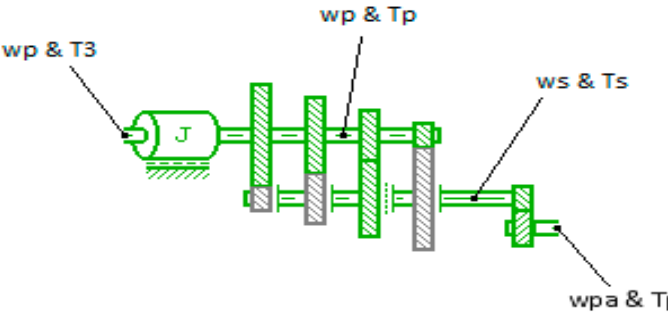
Figure 3. Operation modes of the gear of a gearbox.